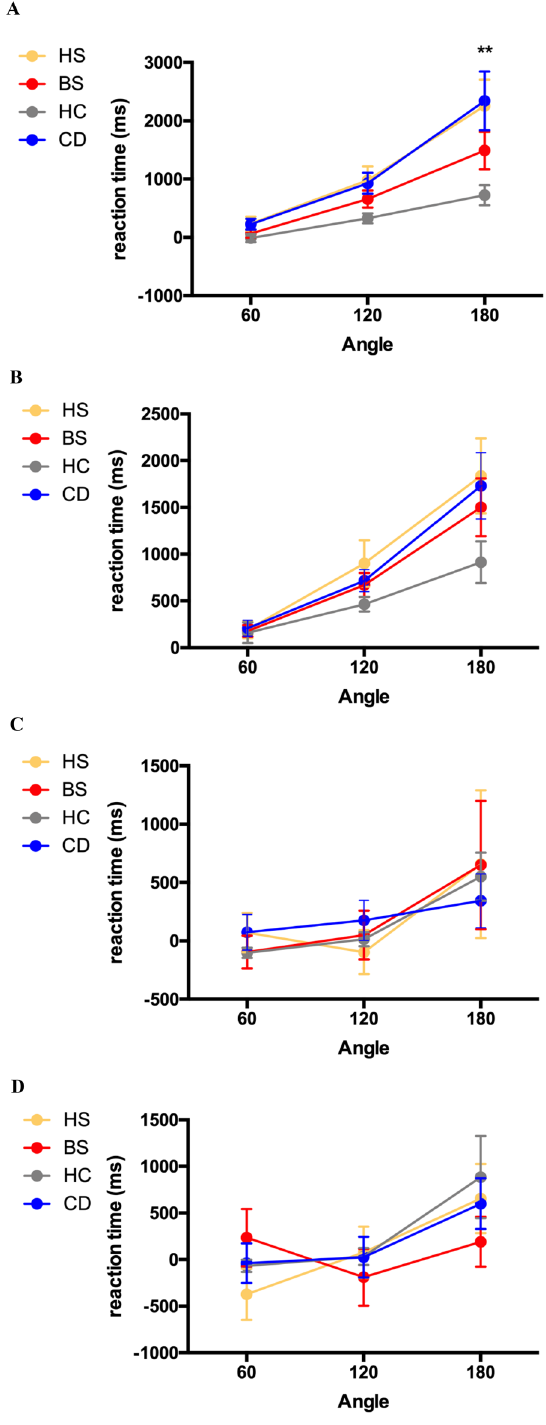
Figure 2. (A – D ) Reaction time relative to no rotation (0°) for each group on the Mental Rotation of ( A ) hands, ( B ) foot, ( C ) head, and ( D ) cars. BS: blepharospasm; CD: cervical dystonia; HC: healthy control; HS: hemifacial spasm, ** p <